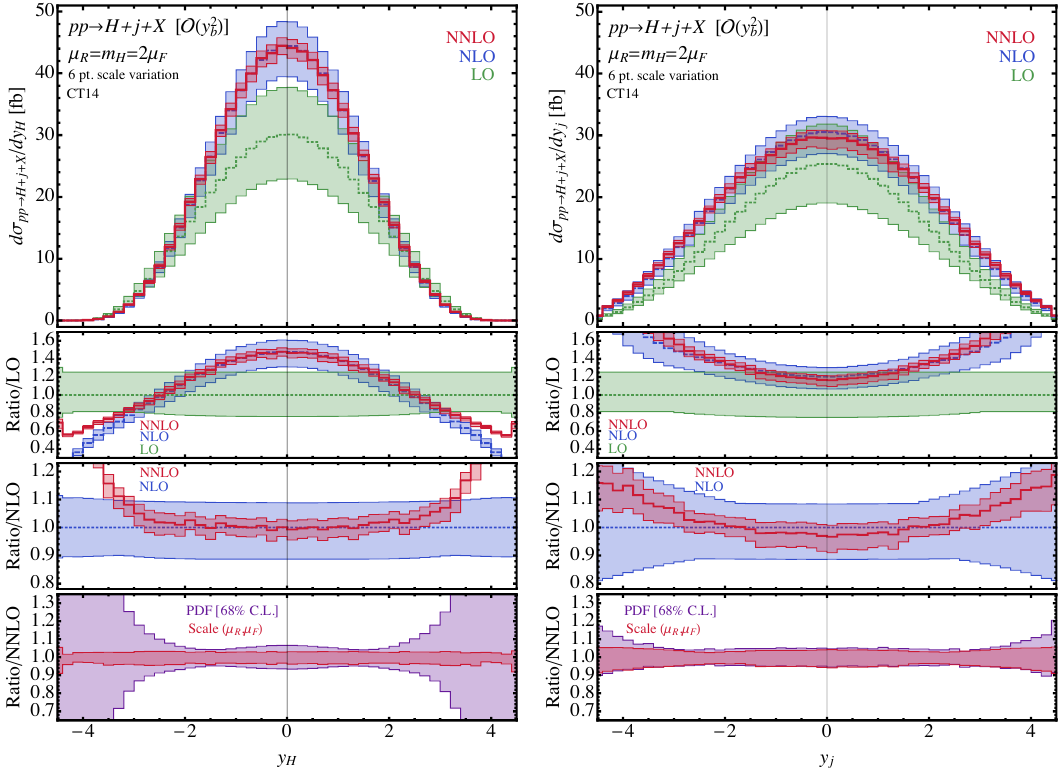
Figure 8 . Distributions of the rapidity of the Higgs boson ( y H , left) and leading jet ( y j , right) at LO, NLO, and NNLO accuracy. The top panel shows the distribution, while the lower panels present ratios to the LO, NLO, and NNLO central predictions. In addition to the six-point scale variation, the lower panel presents estimates of PDF uncertainties at 68% C.L. (the other panels only include the scale